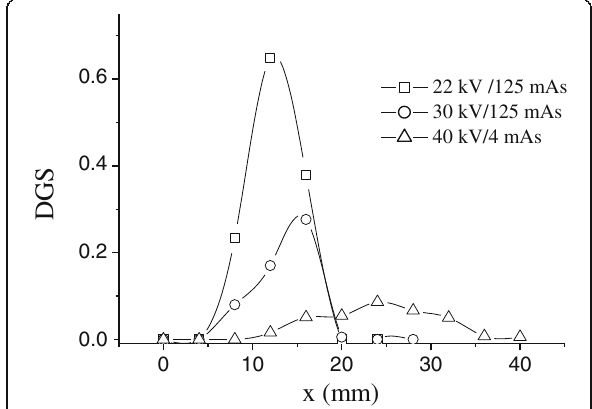
Fig. 8 Differences in the grey-scale intensities (DGS) obtained for the extreme samples GAC-virgin and GAC-Top (exhausted) DGS